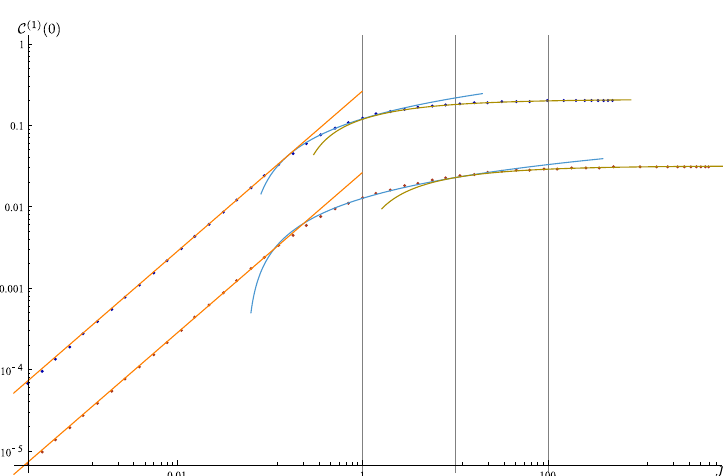
Figure 1. Exact C (1) (0)- (cid:14)t relations in log-log scale. Red and blue dots correpond to b = 0 : 01 and b = 0 : 1 respectively. The orange, blue, and yellow (cid:12)tting curve are y = cx d , y = P + Q log x , and y = P 0 + Q 0 x (cid:0) 1 = 2 , respectively. The linear (cid:12)tting coe(cid:14)cient d = 0 : 985146 for b = 0 : 1 and d = 0 : 984975 for b = 0 : 01, which implies the linear relation between C (1) (0) and (cid:14)t in fast quench regime.